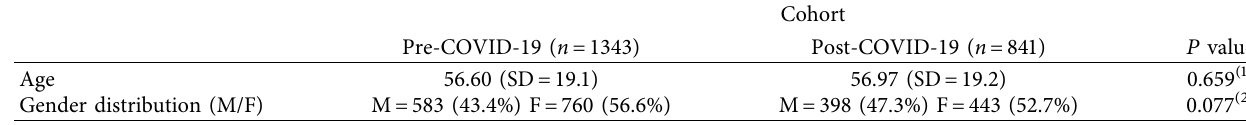
Table 1: Demographic distribution of the studied sample.